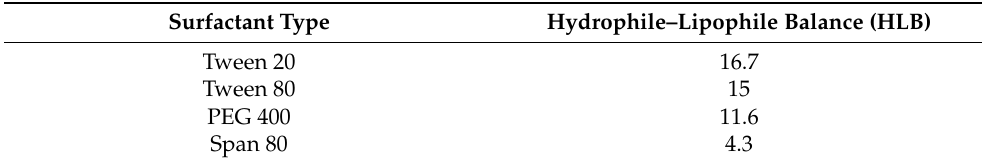
Table 1. HLB number for pre-selected surfactants for screening assay.